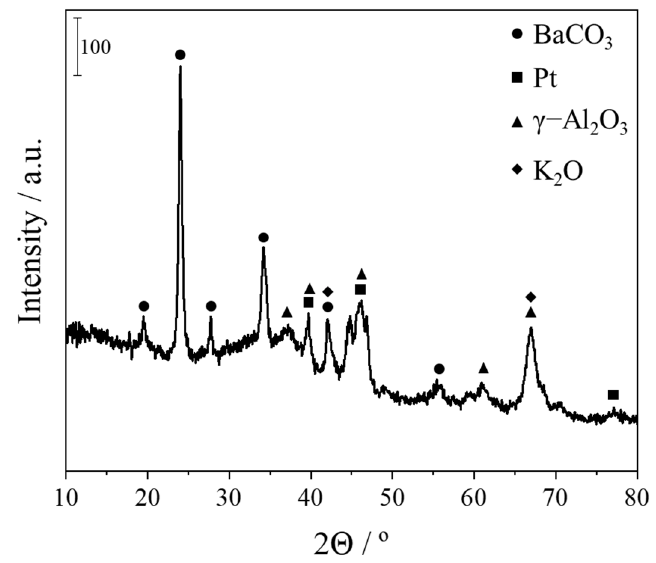
Figure 1. X-ray diffraction pattern of the NSR catalyst 0.4Pt-3.5Ba-1.5K/Al 2 O 3